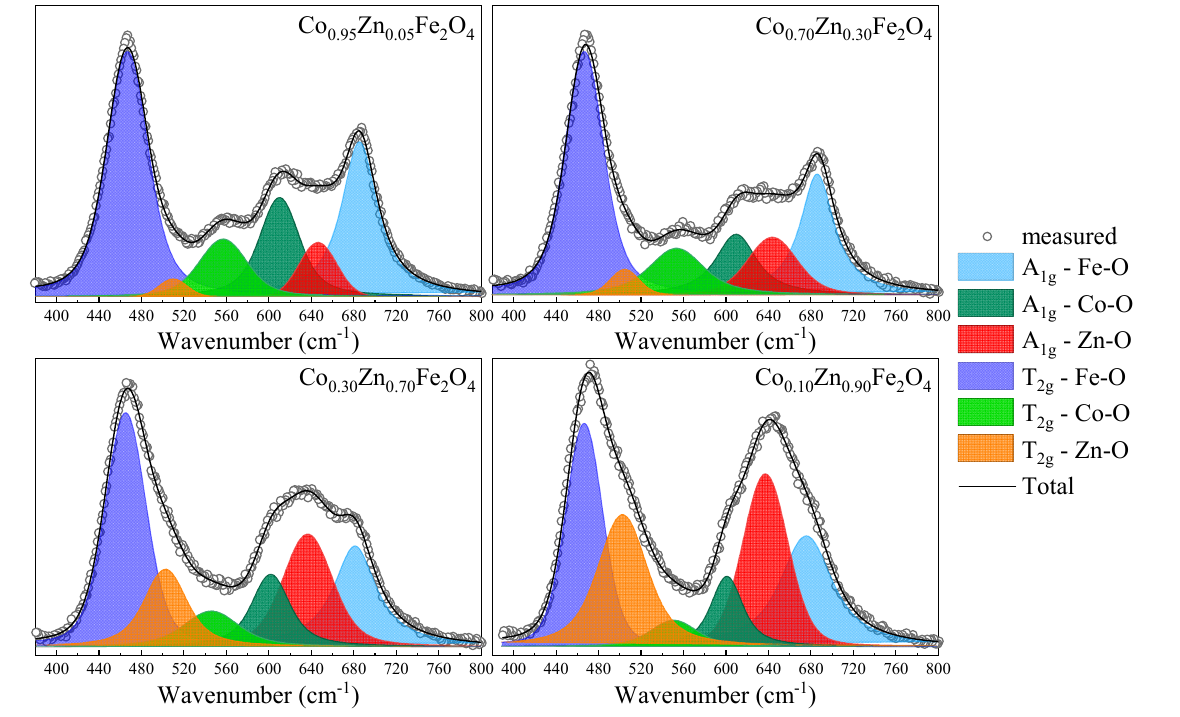
Figure 6. Fitting results for Raman spectra of Co 1- x Zn x Fe 2 O 4 nanoparticles.